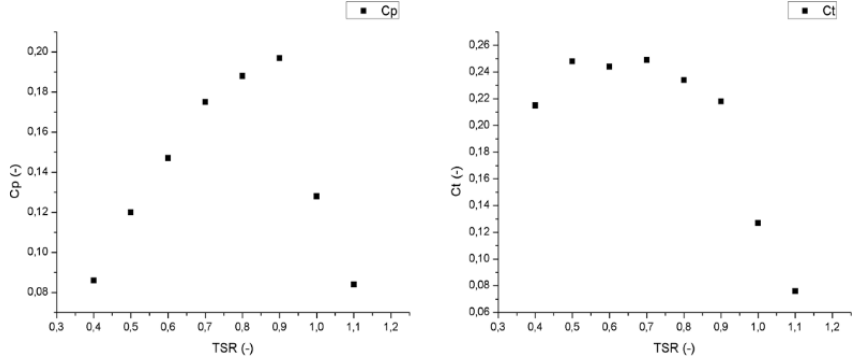
Figure 12: Graph of correlation a) C p with TSR and b) C t with TSR on Rotor Three Stage 120 ∘ .